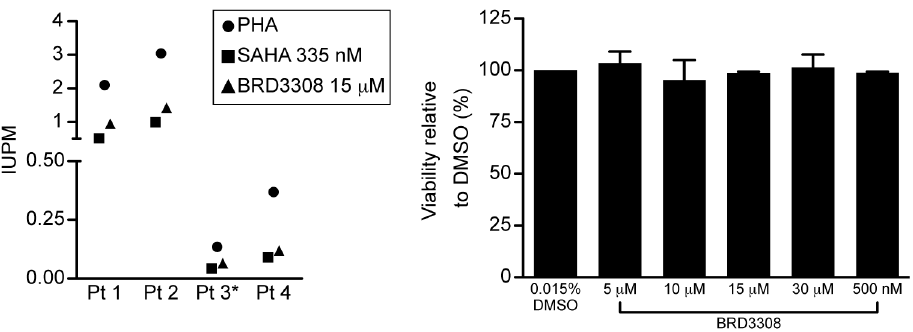
Figure 7. Inhibition of HDAC3 induces outgrowth of HIV-1 from latently infected patient cells ex vivo. A. HIV-1 outgrowth from latently infected CD4 + T cells following overnight exposure to 15 m M BRD3308 or 335 nM SAHA. The frequency of viral outgrowth following mitogen stimulation of HDAC inhibitor exposure is expressed as infected cells per million resting CD4 + T cells (IUPM). In four patients (Pt 1, Pt 2, Pt 3, and Pt 4) exposure to BRD3308 induced a comparable frequency of outgrowth to that observed following exposure to SAHA. *IUPM for PHA for Pt.3 is obtained from three prior assays; all other assays are contemporaneous. B. PBMCs were exposed to 5, 10, 15, or 30 m M of BRD3308, and viability was measured. The results are expressed as the viability relative to the control DMSO condition. BRD3308 does not significantly affect viability of